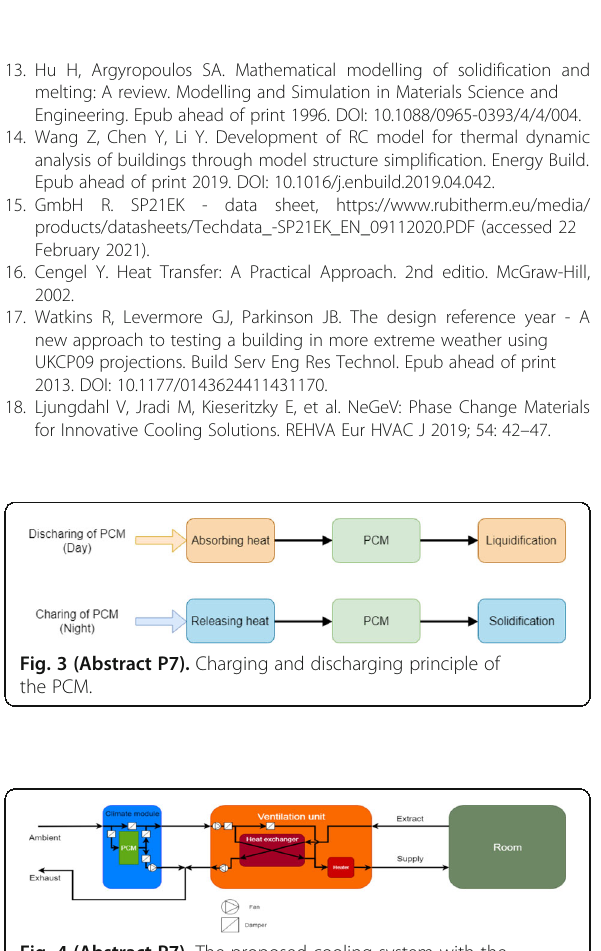
Fig. 4 (Abstract P7). The proposed cooling system with the interactions between its components